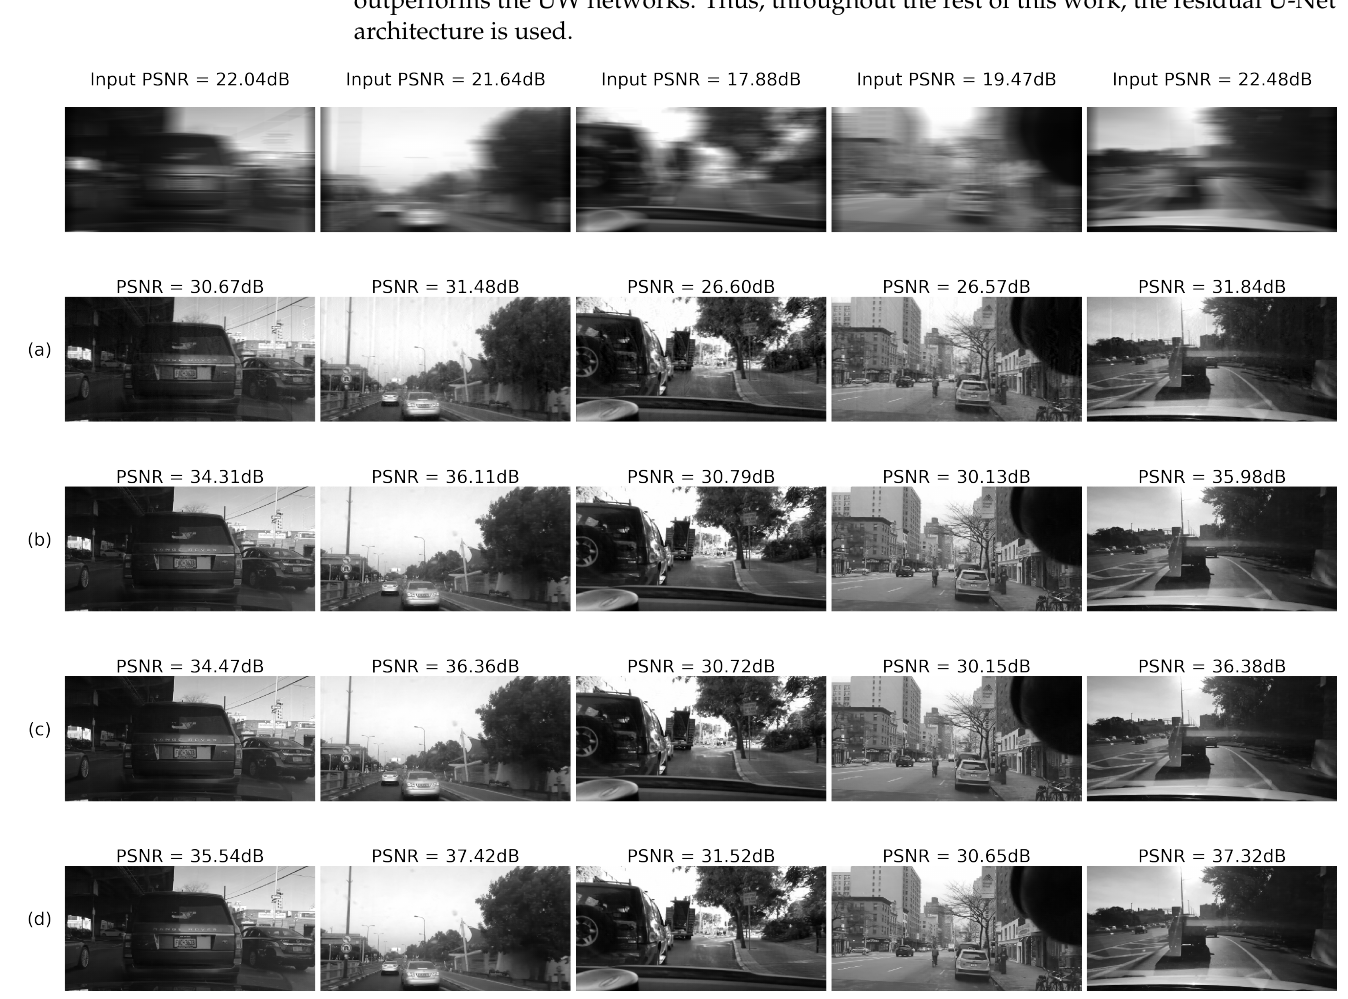
Figure 9. Two-step image deblurring for a set of images: ( a ) Tikhonov Deconvolution with λ = 7.5 × 10 − 3 ; ( b ) Initial + UW-64; ( c ) Initial + UW-128; ( d ) Initial + residual U-Net. Table 1. Typical performance for different test